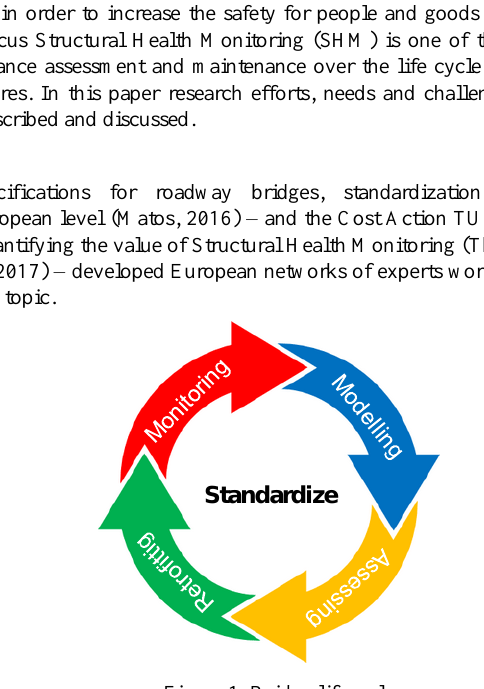
Figure 1. Bridge